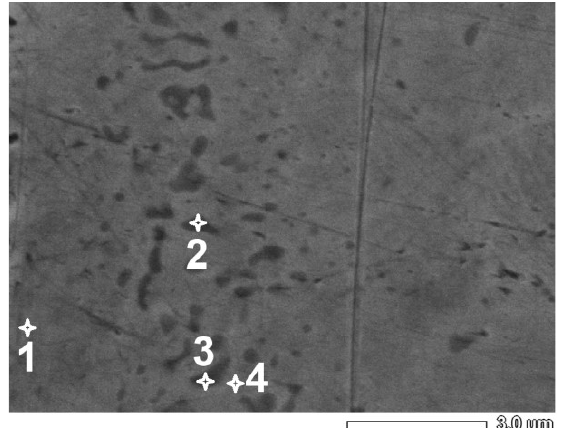
Figure 7. Back scattering electron-image for the cross-sections of the sample ST4. Points with nickel/titanium contents (see Table 1) correspond to the marked points in the SEM image. Table 1. Results of the Energy dispersive X-ray spectroscopy measurements for the cross-sections of the sample ST4 corresponding to the points marked in the SEM image, Figure 7. Point number